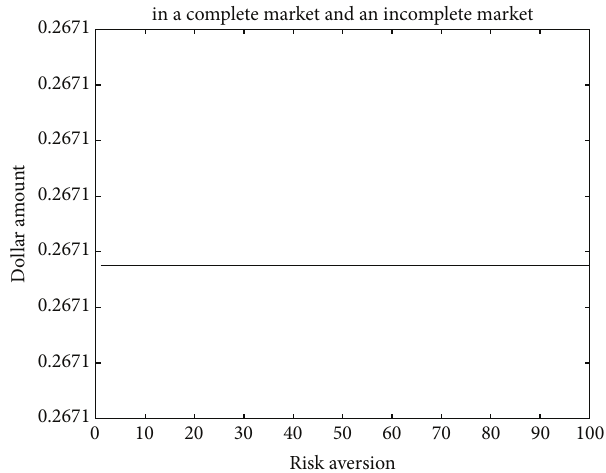
Figure 3: Relative differences of the average total dollar amount invested in stocks between the two markets.